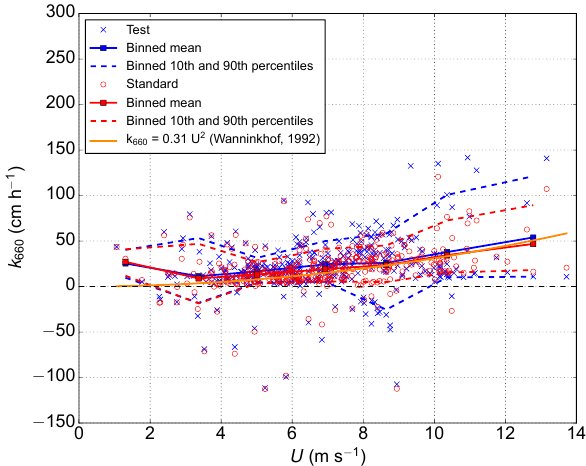
Figure 8. Measured gas transfer velocities as a function of wind speed. The orange line is the parametrization by Wanninkhof (1992).